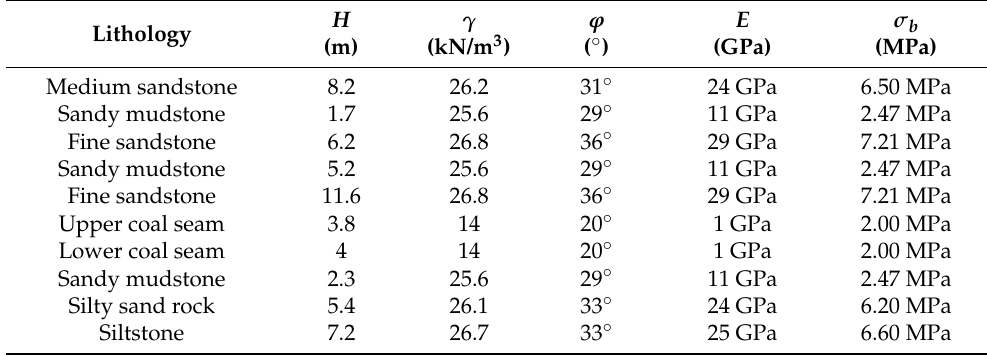
Lithology Table 2. Physical and mechanical parameters of rock strata.